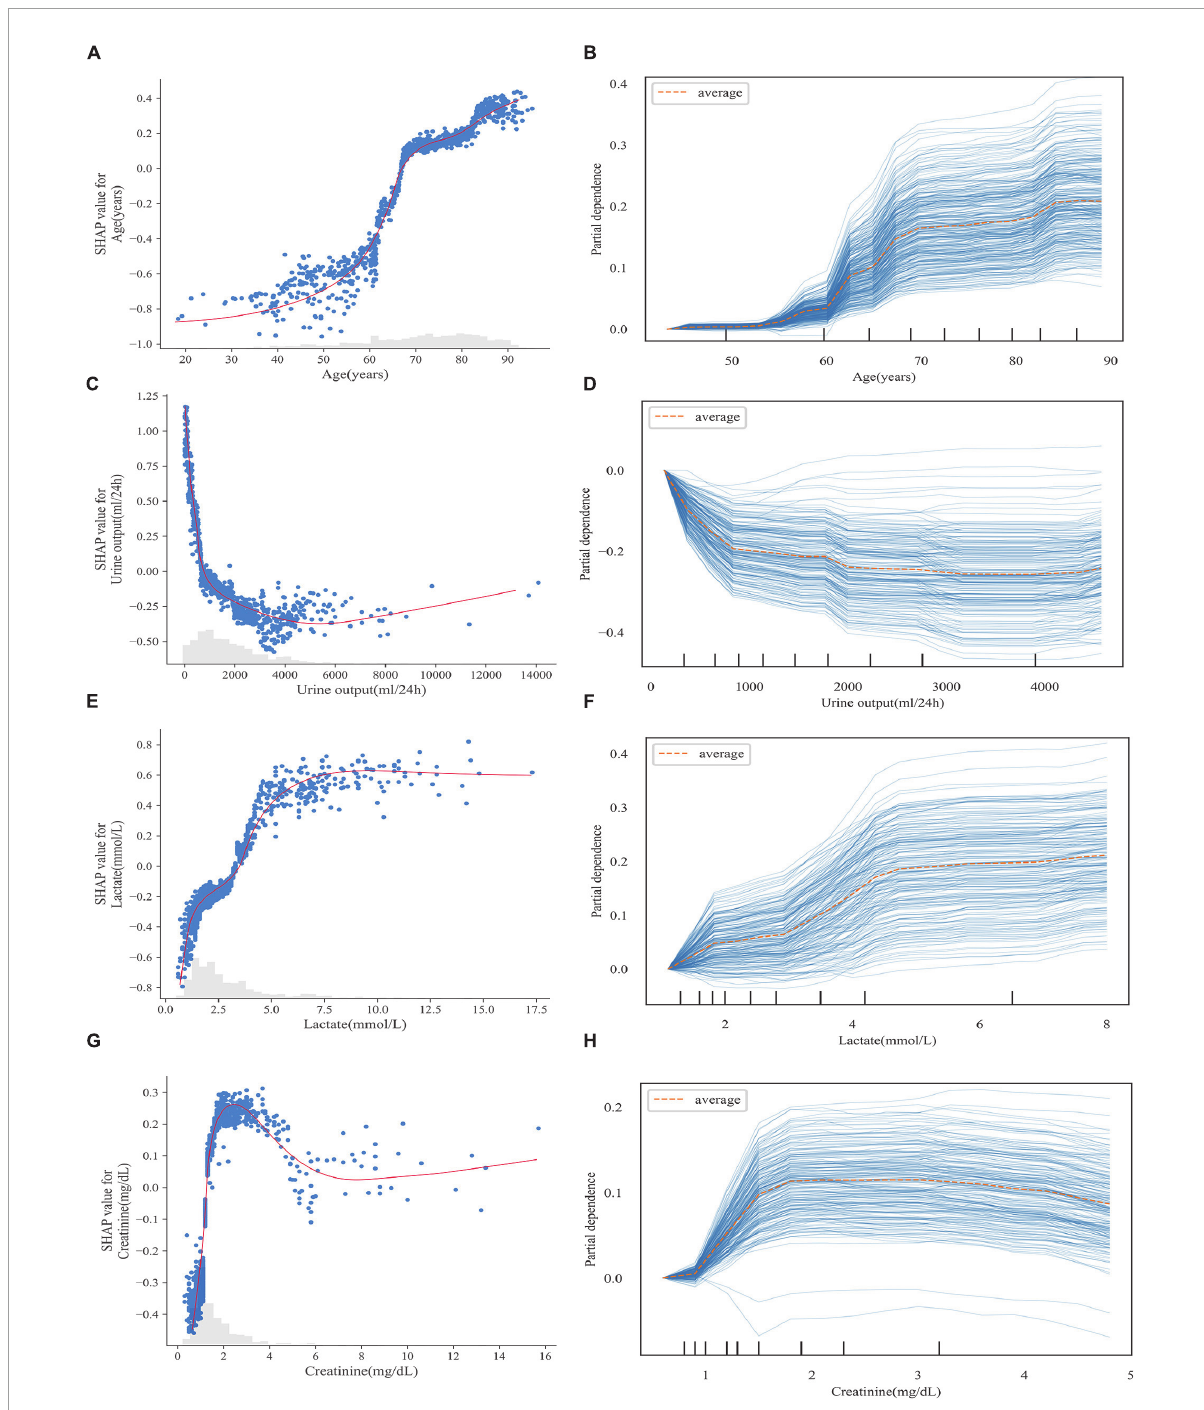
FIGURE6 Scatter plot (A,C,E,G) and PDP (B,D,F,G) of continuous variables in S-CatBoost model. (A,B) Age; (C,D) urine output; (E,F) lactate; (G,H) creatinine. PDP, partial dependence plot; S-Catboost, simplified Catboost model.